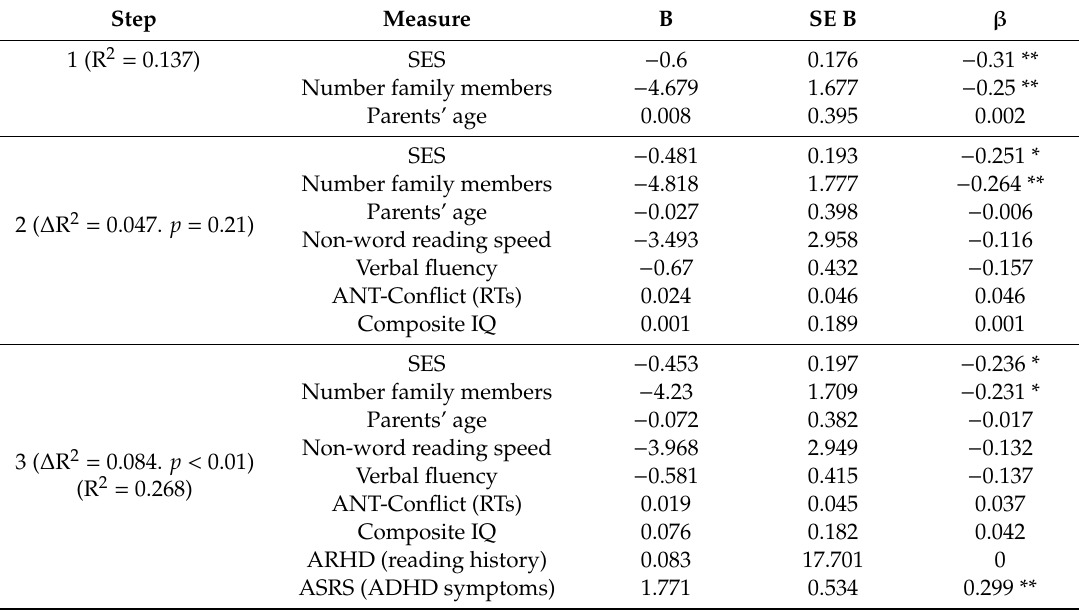
Table 3. Hierarchical regression; dependent variable: Parenting Stress